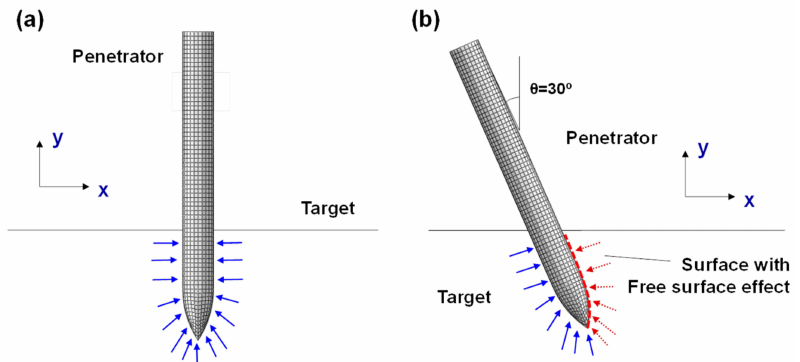
Figure 8. Simulation model for ( a ) normal penetration and ( b ) oblique